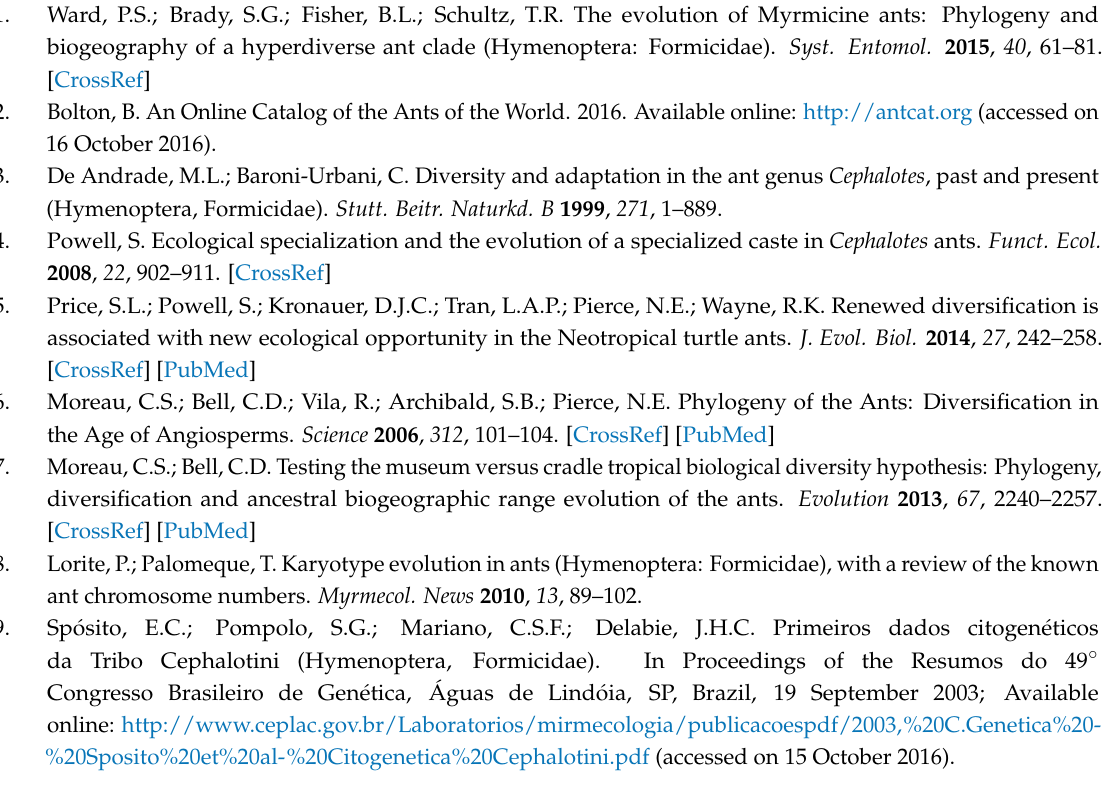
Table S1: Karyomorphometrical analyses of the eight specimens of Cephalotes pusillus (Klug, 1824) analyzed in the study. ∑ TL: total length; KL mean karyotype length (= ∑ TL/2n) ± SD: standard deviation; CV coefficient of variation (= ± SD/KL); Video S1: Cephalotes pusillus (Klug, 1824) digging behavior. The movie shows workers actively unloading the wood fragments from inward